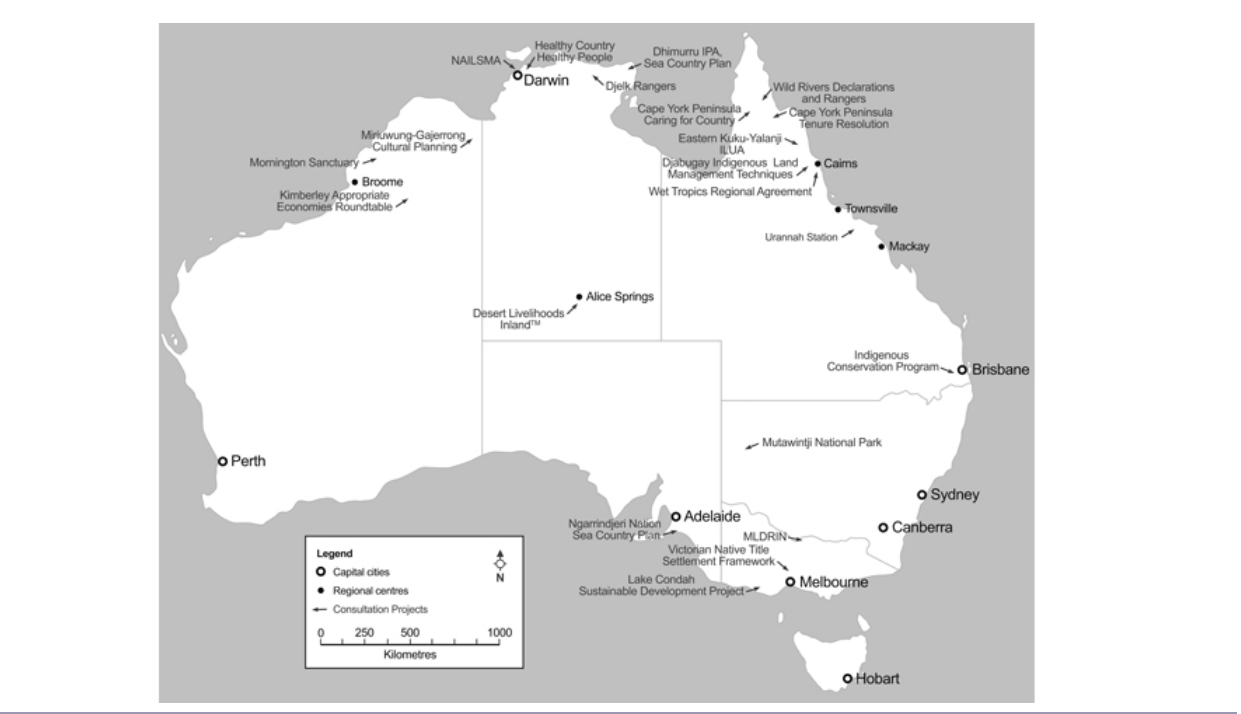
Fig. 1 . Location of case studies in